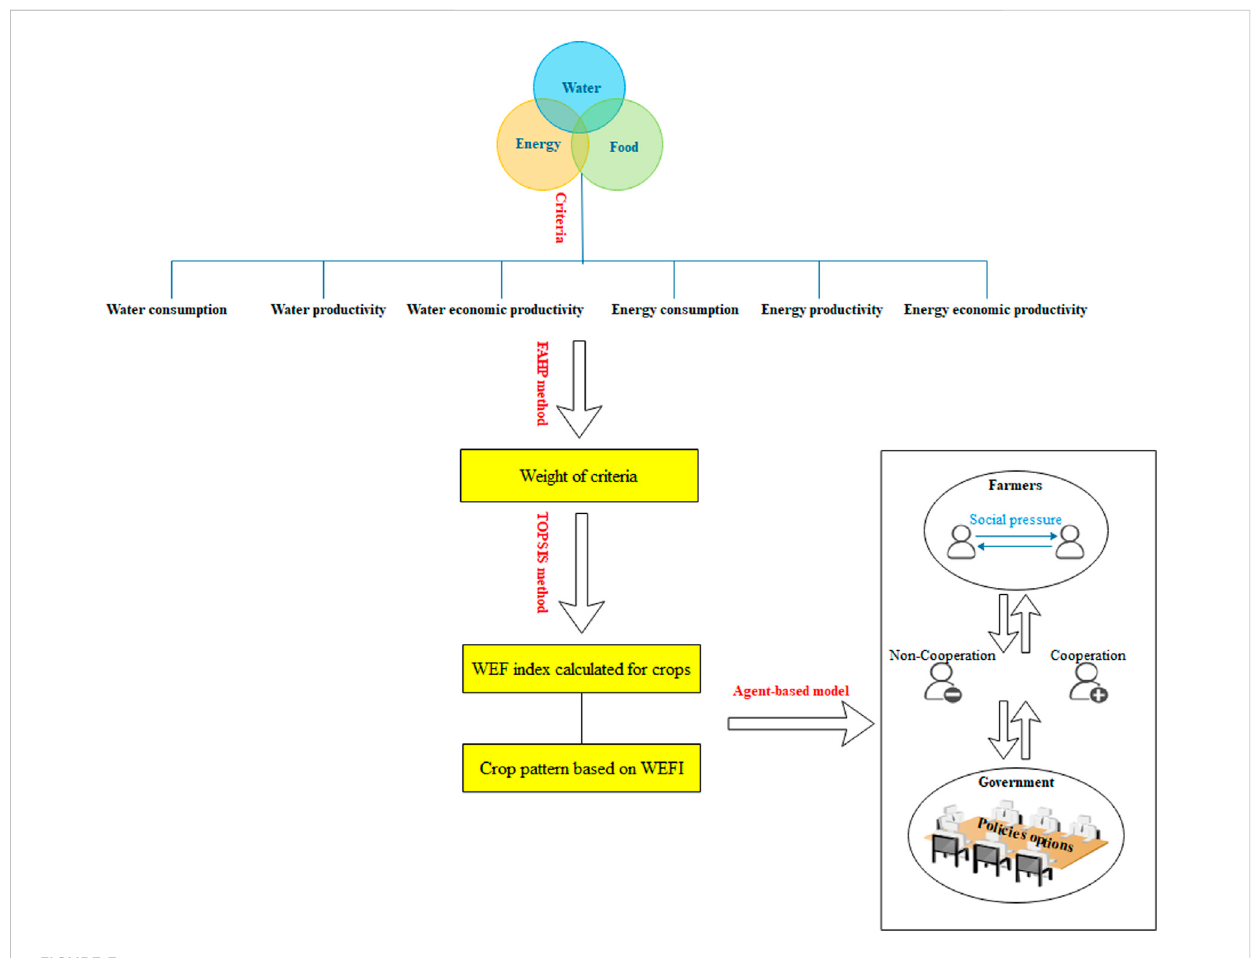
FIGURE 3 Conceptual framework of the present study.